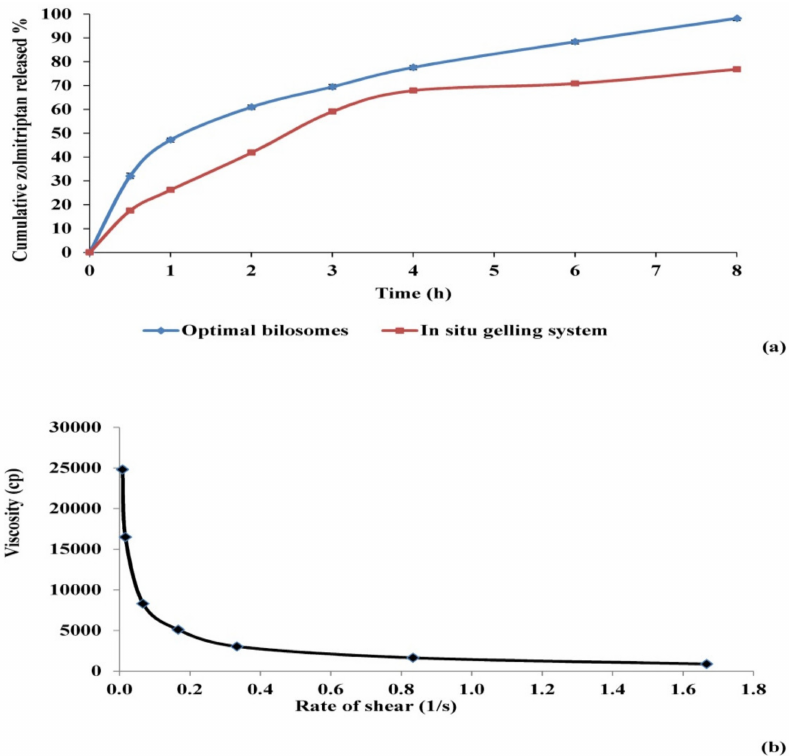
Figure 5. ( a ) Release profiles of zolmitriptan dispersion from the optimal bilosomes and the prepared mucoadhesive in situ gelling system containing them in phosphate buffer saline, pH 7.4; ( b ) Relation between viscosity and rate of shear for the prepared mucoadhesive in situ gelling